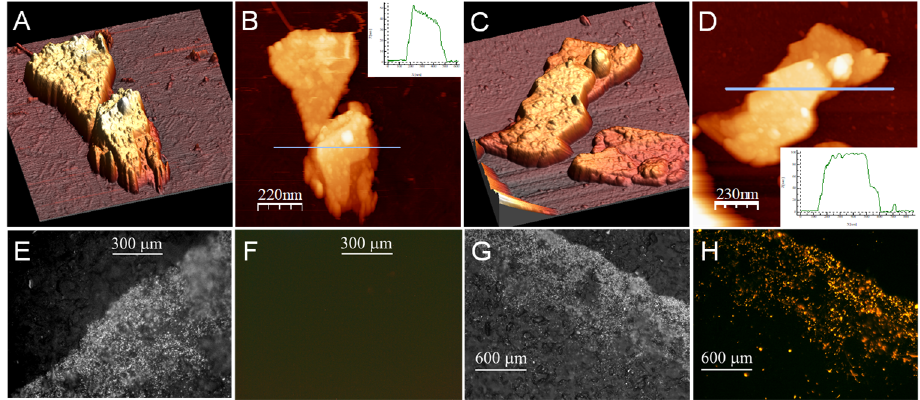
Figure 4. (A, B, C and D) AFM topography images of (A and B) HOPG/MoS 2 -NS and (C and D) Figure 4. ( A – D ) AFM topography images of ( A , B ) HOPG/MoS 2 -NS and ( C , D ) HOPG/MoS 2 - HOPG/MoS 2 -NS/DNA. Optical (E and G) and fluorescence (F and H) microscopy images of (E and NS/DNA. Optical ( E , G ) and fluorescence ( F , H ) microscopy images of ( E , F ) CSPE/MoS 2 -NS (100 × ) F) CSPE/MoS 2 -NS (100x) and (G and H) CSPE/MoS 2 -NS/Apt-TAMRA-SH (50x). and ( G , H ) CSPE/MoS 2 -NS/Apt-TAMRA-SH (50 ×